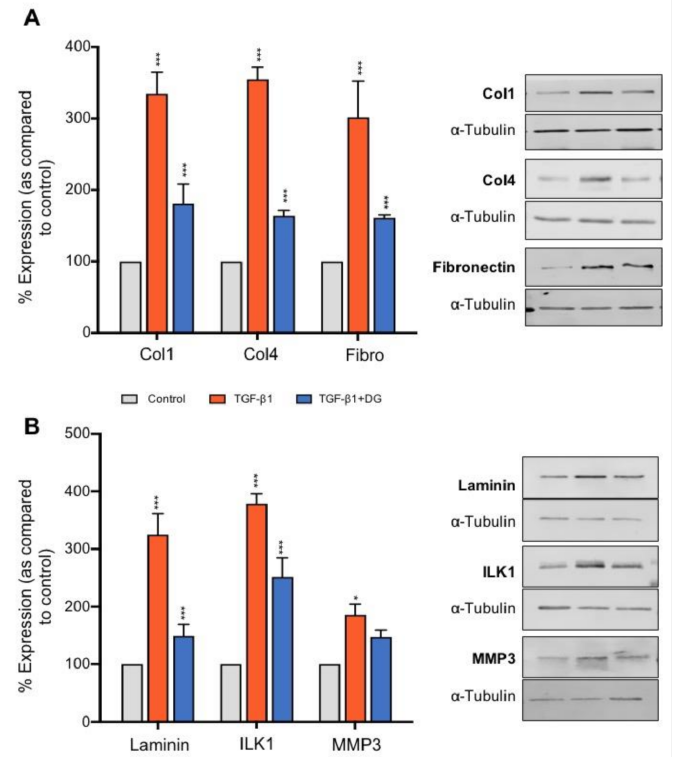
Figure 5. Danegaptide negates TGF β 1-evoked changes in the expression of proteins associated with the extracellular matrix. Primary hPTECs were cultured in low glucose (5 mM) ± TGF β 1 (10 ng/mL) ± danegaptide (100 nM) for 48 h. In panel ( A ), expression of collagen I (Col1), collagen IV (Col4), fibronectin (Fibro) and laminin (panel ( B )) was assessed via Western blotting. TGF β 1 upregulated extracellular matrix (ECM) protein expression, an effect reduced by danegaptide (100 nM). Similarly, danegaptide partially reversed TGF β 1-evoked changes in matrix metalloproteinase 3 (MMP3) and integrin-linked kinase 1 (ILK1). Representative blots are shown, with expression normalised by re- probing for α -tubulin as a loading control. Bars correspond to their associated lanes in the respective blot. Results are presented as the mean ± SEM ( n = 3; * p < 0.05, *** p < 0.001; one-way ANOVA and Tukey’s